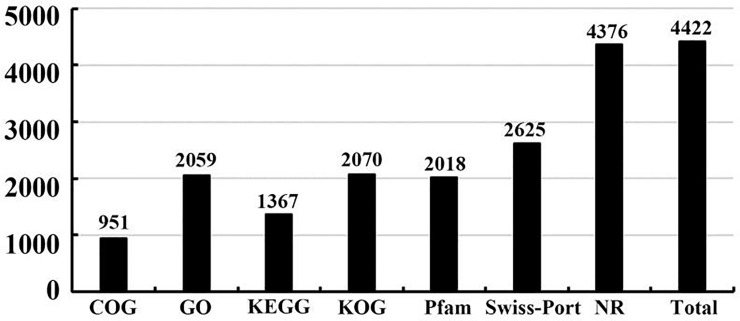
Unigenes numbers annotated in the seven public databases.